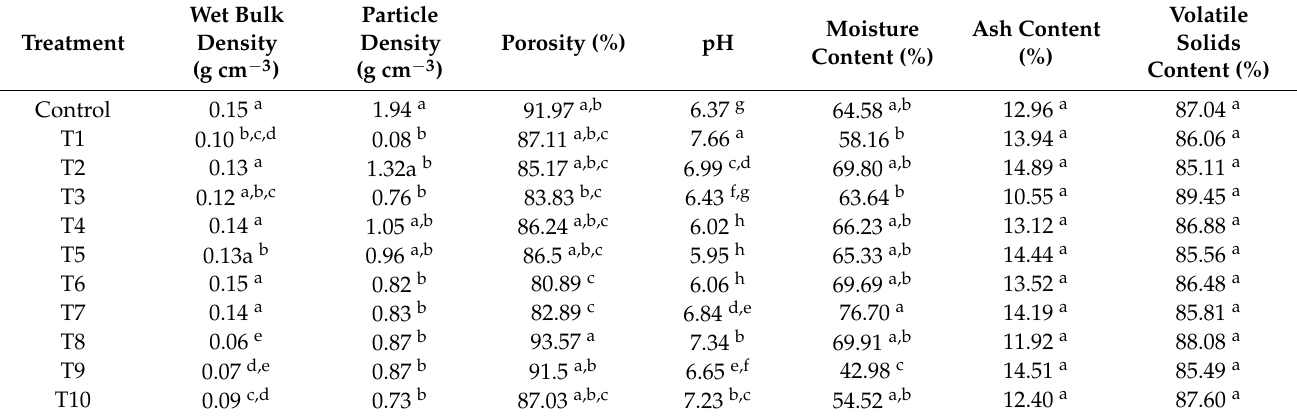
Table 2. Physical properties, pH, moisture content, ash content, and volatile solids of